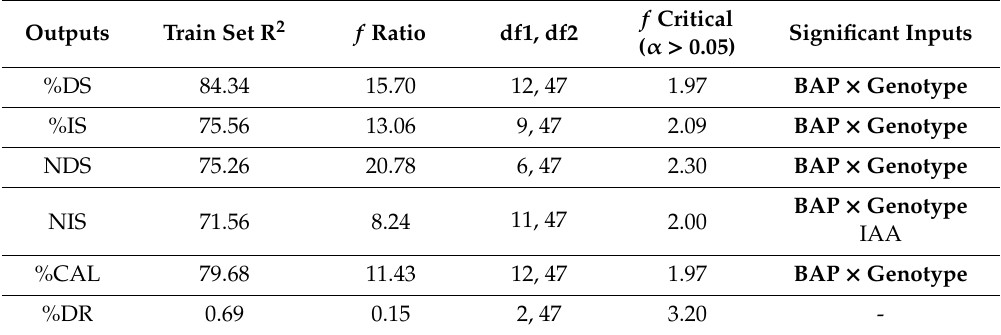
Table 4. Critical factors and quality parameters detected by neurofuzzy logic. Bold inputs correspond to the strongest e ff ect identified for every